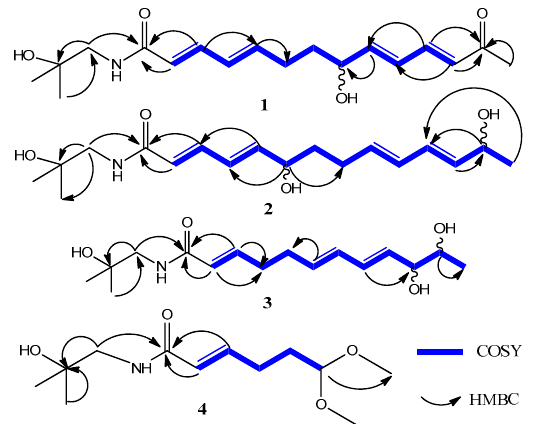
Figure 2. Selected 2D NMR correlations for compounds 1 – 4 .